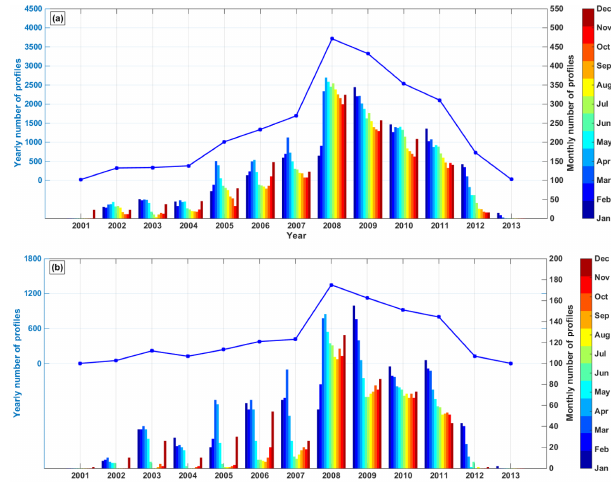
Figure 3. The number of profiles per year (line) and per month (bars) from (a) south of 50 ◦ S to the Antarctic continent and (b) south of 60 ◦ S to the Antarctic continent, between 70 ◦ W and 40 ◦